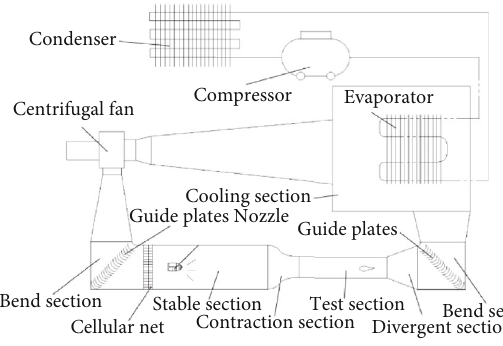
Figure 1: Principle of icing wind tunnel.